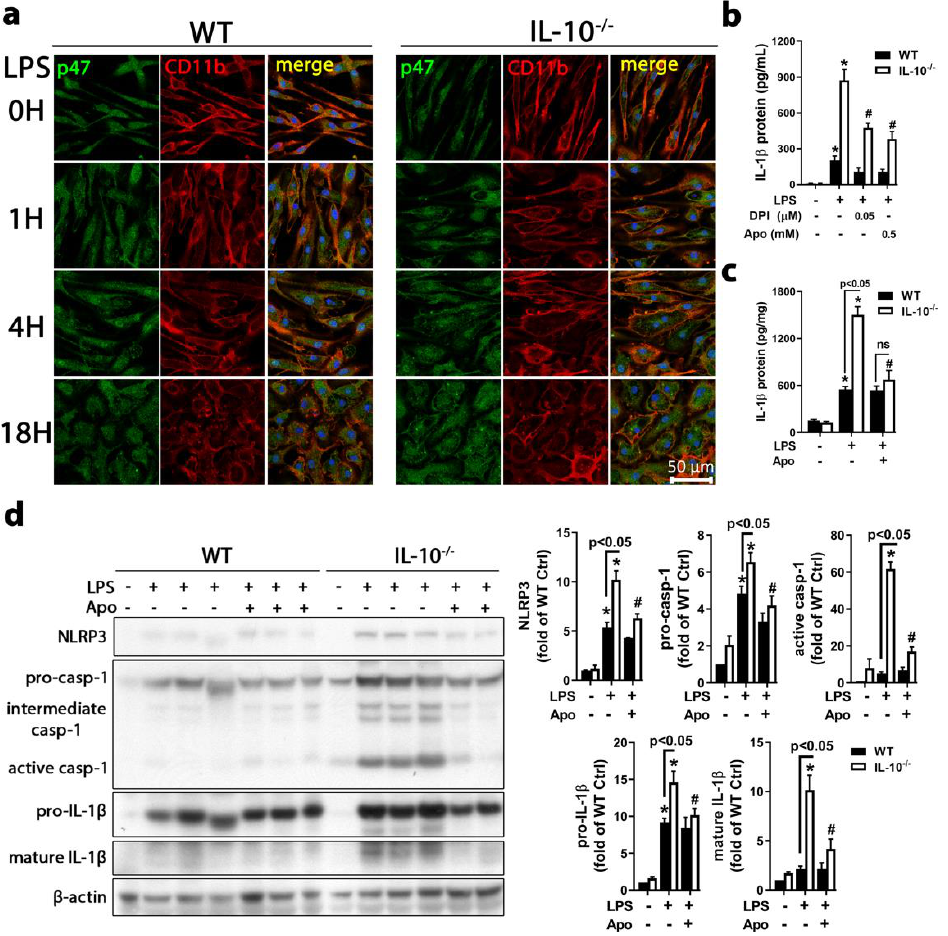
Figure 4. Blockage of NOX2-derived ROS inhibited synthesis and activation of NLRP3 inflammasome and consequent IL-1 β maturation. ( a ) The membrane translocation of cytosolic p47 in IL-10 − / − microglia was detected at 1 h after LPS treatment and became more profound after prolonged treatment. LPS-treated WT microglia displayed less membrane staining of p47 as compared with time-matched IL-10 − / − microglia. ( b ) Pretreatment of microglia-enriched cultures with NOX2 inhibitors DPI and apocynin for 30 min significantly attenuated IL-1 β release detected by ELISA at 48 h after LPS treatment. ( c , d ) WT and IL-10 − / − mice received an intranigral injection of LPS and an i.p. injection of apocynin (50 mg / kg). At 24 h after LPS injection, ELISA ( c ) indicated that apocynin abolished IL-1 β elevation in midbrains of IL-10 − / − mice. Immunoblot analysis ( d ) revealed that upregulation of NLRP3, pro-casp-1, and pro-IL-1 β , as well as cleavage of pro-caspase-1 and pro-IL-1 β in the midbrain of IL-10 − / − mice were blocked by apocynin. Results are the mean ± SEM, and significance was determined by two-way ANOVA with Tukey’s multiple comparisons for b ( n = 4), c ( n = 4–5), and d ( n = 3–4). * p < 0.05 as compared with the corresponding vehicle-treated control and # p < 0.05 as compared with the corresponding LPS-treated groups. Fluorescent images are representative of three independent experiments. Apo, apocynin and CASP-1,